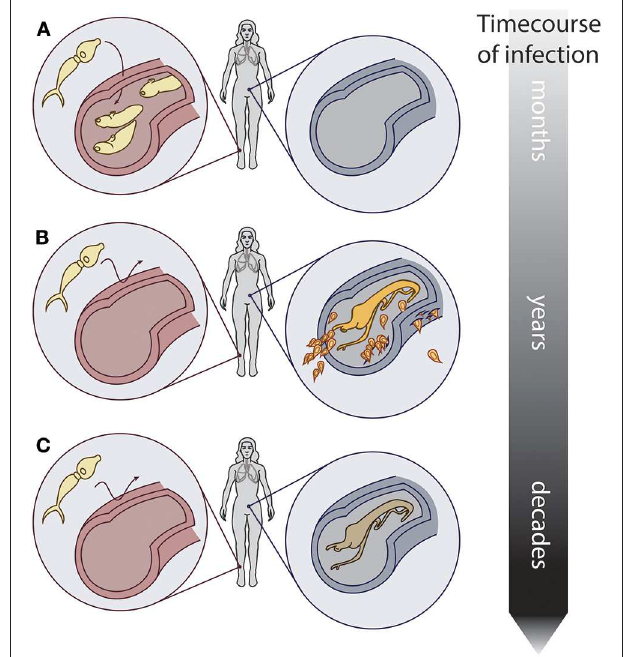
FIGURE 2 | Conceptual hypothesis showing the relationship between worm reproductive senescence, concomitant immunity, and host infection. Over the course of infection in a host: (A) Schistosomes infect a naïve host. (B) Established adult worms prevent new infections via concomitant immunity, and produce eggs that induce pathology. (C) Older worms still prevent new infections via concomitant immunity, but produce few to no eggs due to reproductive senescence. Artwork: Kate